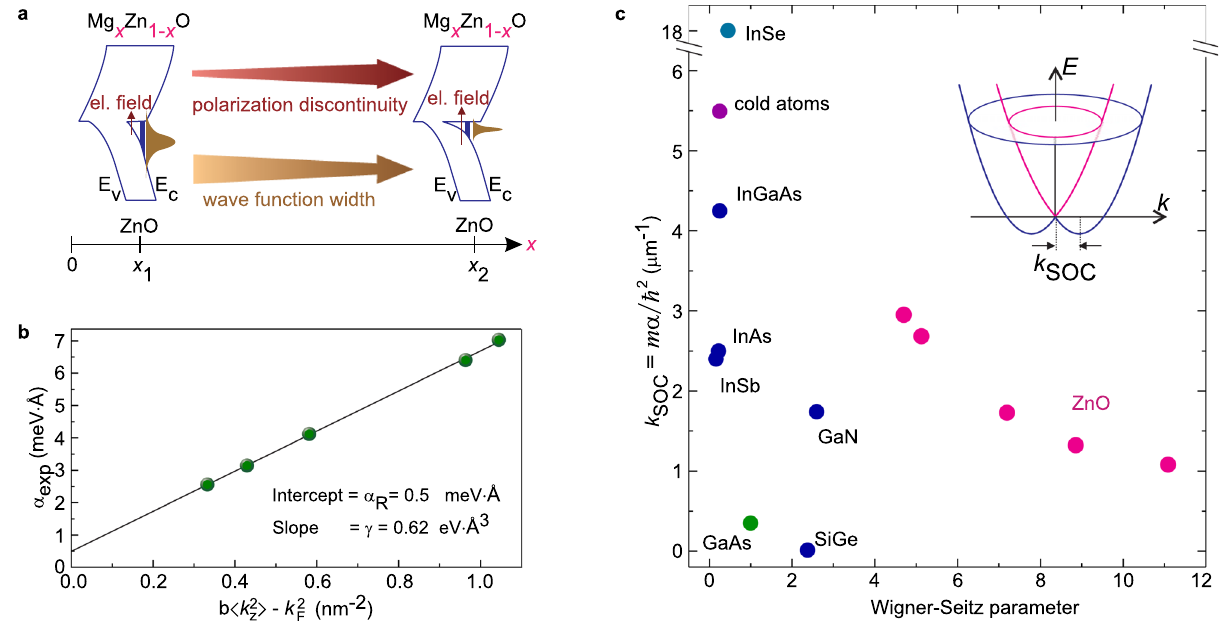
Fig. 4 Spin – orbit coupling effect in semiconductor 2D systems. a Schematic representation of the con fi nement potential change with Mg content. Interfacial electric fi eld increases, while the wavefunction shrinks, as Mg-content increases. b Estimate of Rashba α R and Dresselhaus γ spin – orbit coupling coef fi cients. Here b = 3.85 for our Fermi wavevector range k F ¼ by the wavevector k SOC and Coulomb strength given by the Wigner-Seitz parameter r